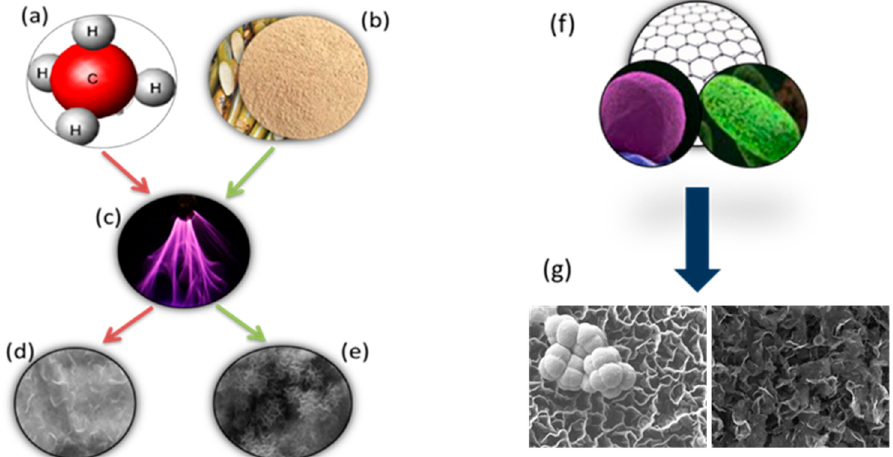
Figure 7. Comparative evaluation of the antibacterial efficacy of graphene nanowalls synthesised from different precursors. High-cost, high-purity conventional, i.e., methane ( a ), and low-cost, natural carbon, i.e., sugarcane bagasse ( b ) sources are converted using low-temperature plasma process ( c ) into high-quality graphene sheets ( d , e ). When bacterial cells are exposed to thus-fabricated surface-immobilised graphenes ( f ), anti-bacterial activity of graphene is observed to differ ( g ), expressed in terms of cell attachment and number of colony-forming units.